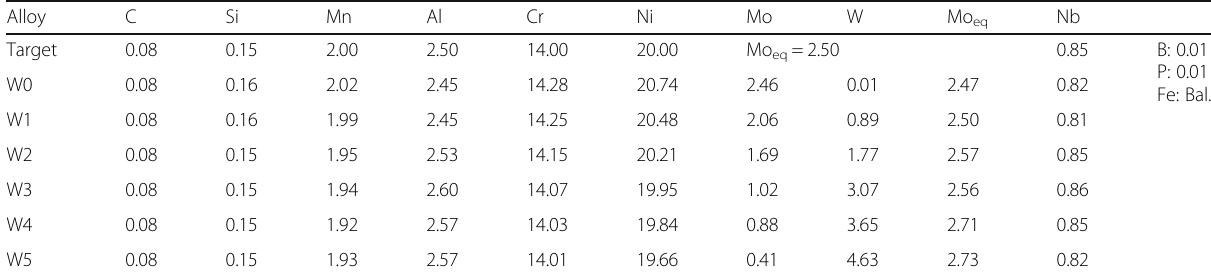
Table 1 Chemical compositions of the alloys (in